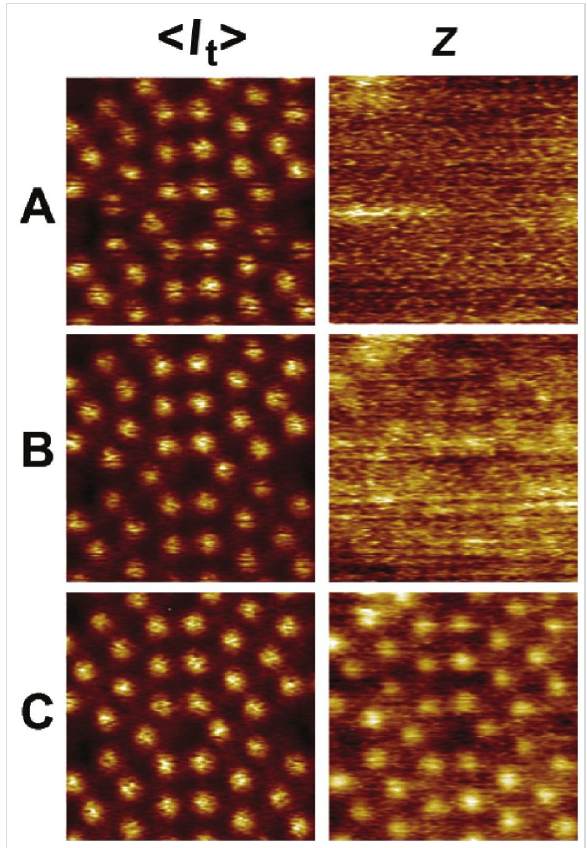
Figure 7: A set of constant-frequency-shift maps ( z ) and simultane- ously recorded average-tunneling-current maps (< I t >). The frequency- shift setpoints for topographic imaging are (A) − 35 Hz, (B) − 40 Hz and (C) − 45 Hz.